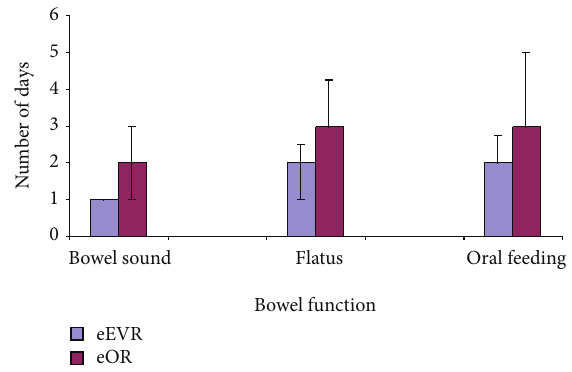
Figure 11: Bowel sound ( 𝑃 = 0.02 ), flatus ( 𝑃 < 0.01 ), and oral feeding ( 𝑃 < 0.01 ), eEVAR versus eOR (median, IQR; Mann- Whitney 𝑈